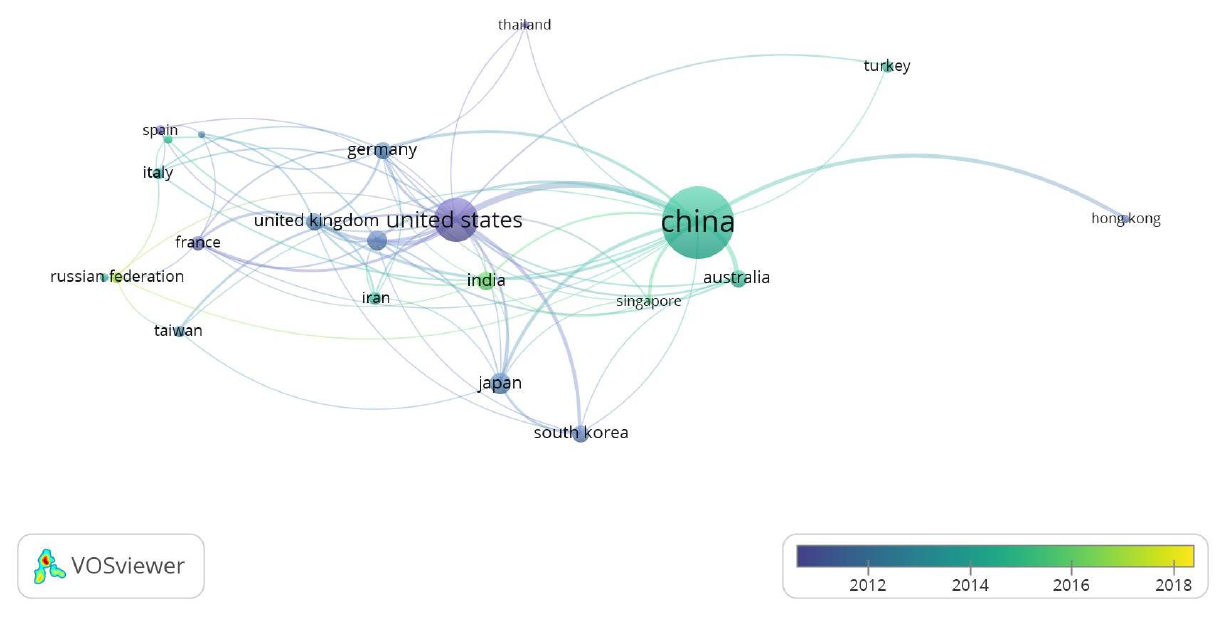
Figure 6. A visual representation of the cited countries.